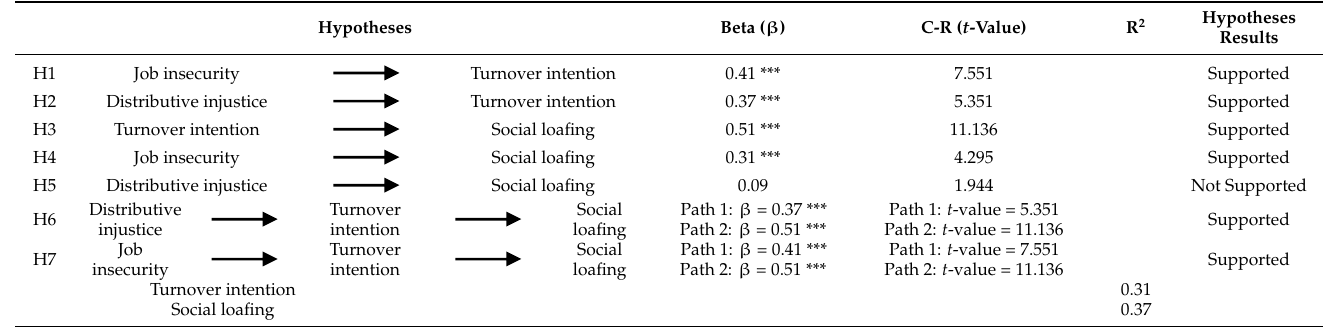
Table 3. Result of a structural model.